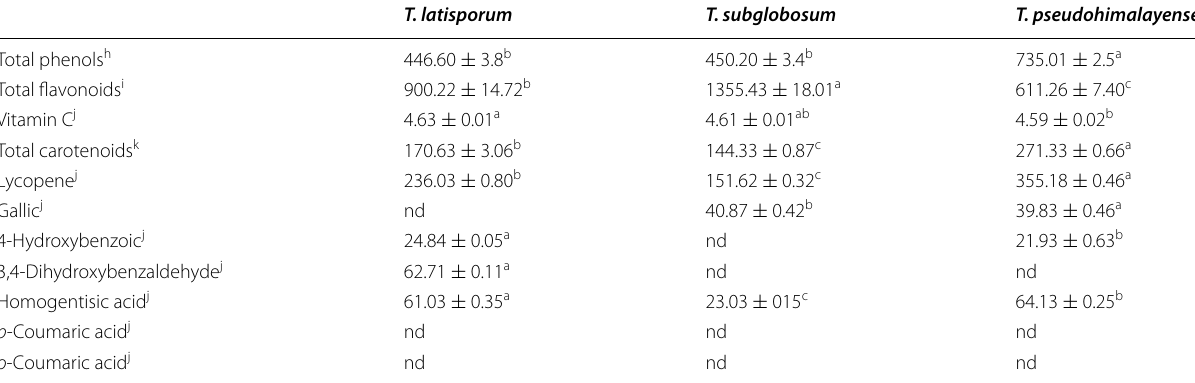
nd not detected a,b,c In each row, the different letters represent significant differences between samples (p < 0.05); d % or g/100 g dw; e kcal/100 g; f mg/100 g dw; g % of total FA; h mg of GAE/100 g extract; i mg of Rutin/100 g extract; j g/100 g extract; k mg of β-carotene/100 g